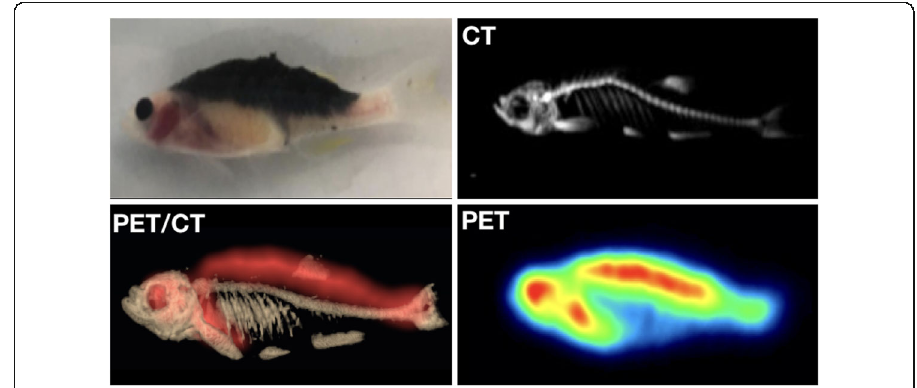
Fig. 4 FDG PET/CT of zebrafish with a dorsal tumour imaged at 28